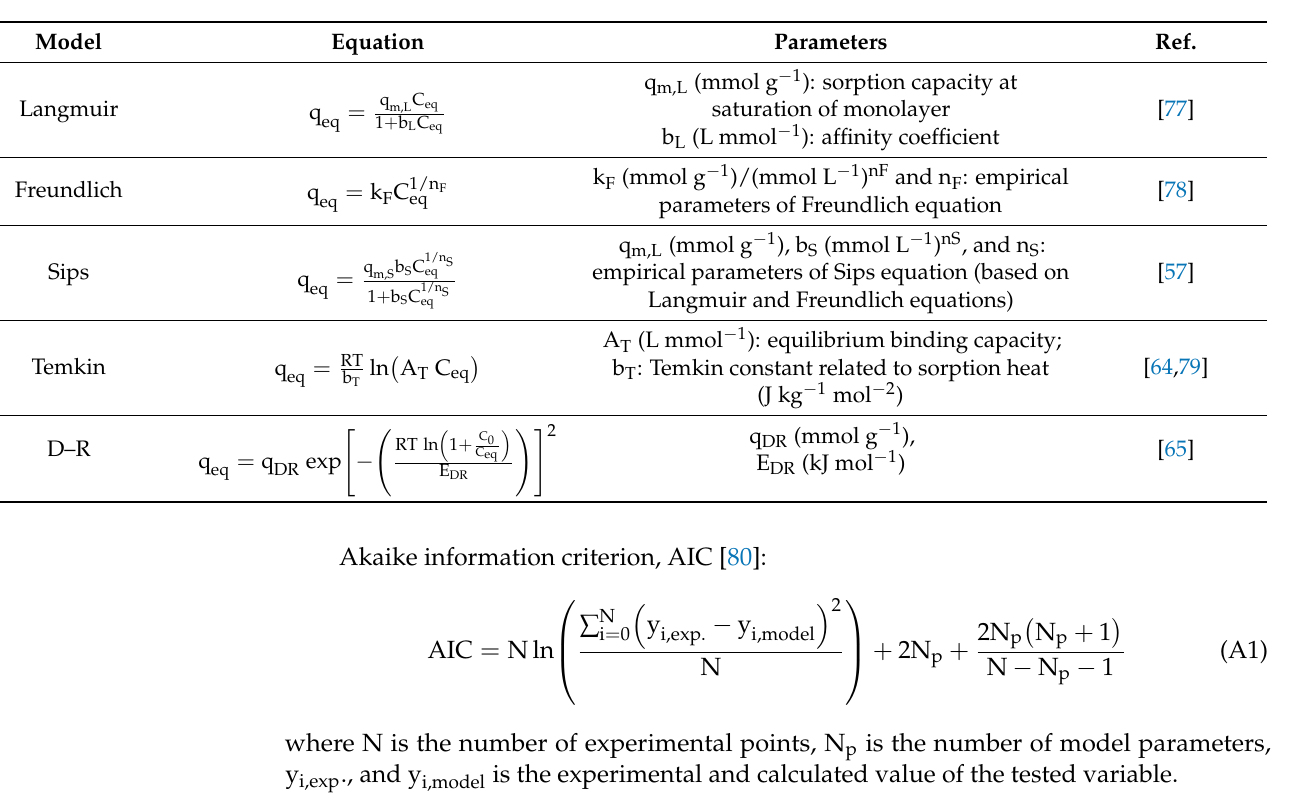
Figure A14. Modeling of Cs(I) and Sr(II) sorption isotherms (onto APO-PEI beads) using the Langmuir dual site model (LDS) (for experimental conditions, see Figure A12).